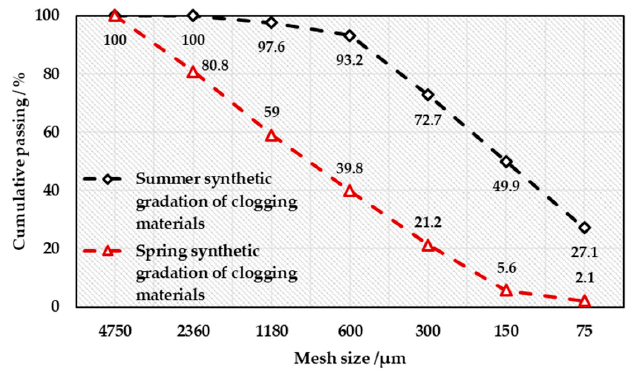
Figure 7. The synthetic gradations of clogging materials in spring.